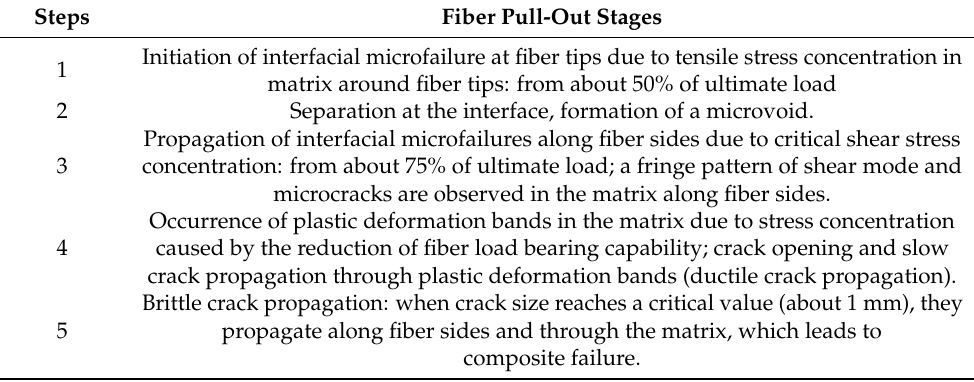
Table 5. Short fiber pull-out stages [95].